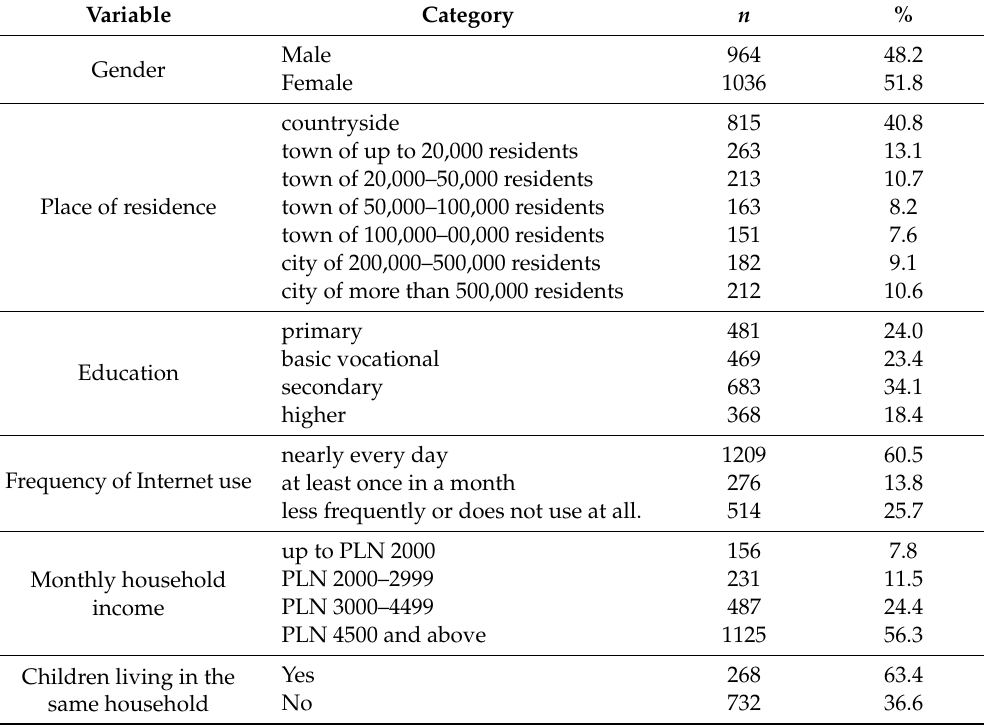
Table 1. Descriptive statistics for the sociodemographic variables for the test group ( n =